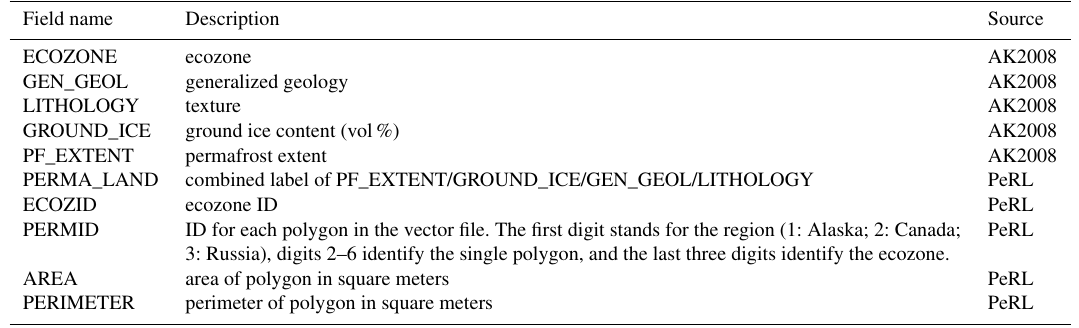
Table B1. Attributes contained in the polygon attribute table of Alaskan permafrost landscapes (alaska_textunderscore perma_land.shp).